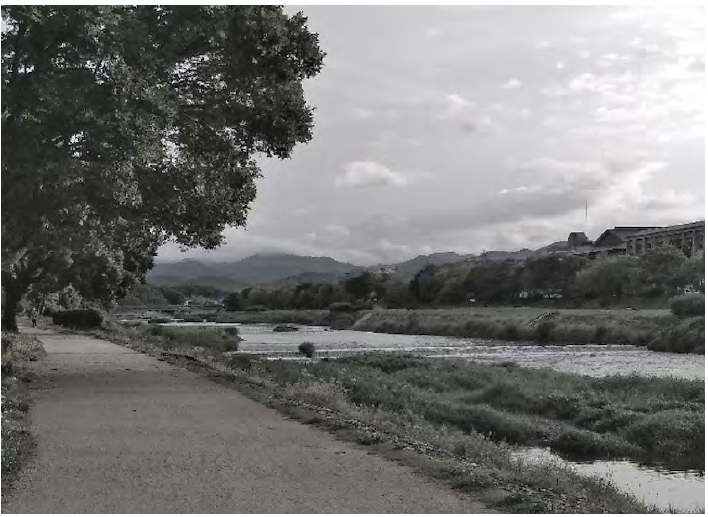
Figure 2. View of Kyoto from the Kamo River Source: Taken by author,